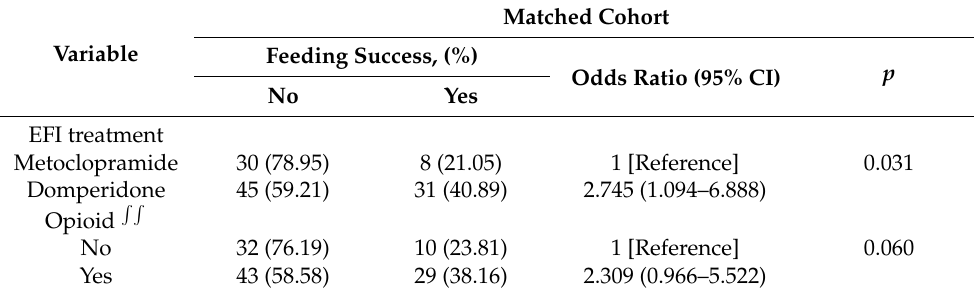
Table 4. Multivariate backward logistic regression model for primary outcome in matched